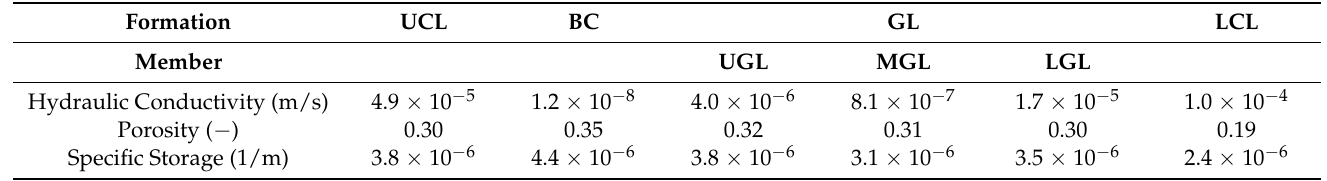
Table 1. Hydraulic conductivity, porosity and specific storage of the geological formations outcropping across the Maltese Islands (average values) [33,34,36–43].